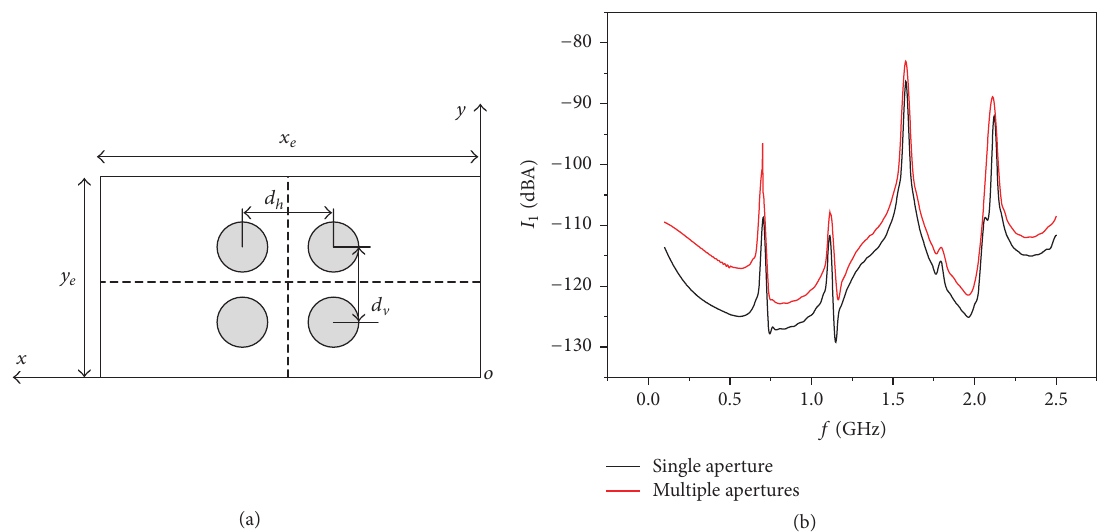
Figure 9: (a) An array of four circular apertures respectively covered by a conductive sheet of thickness t = 1mm and conductivity 𝜎 = 100 S/m. (b) Comparison of the electric current induced at termination load 𝑍 same area.